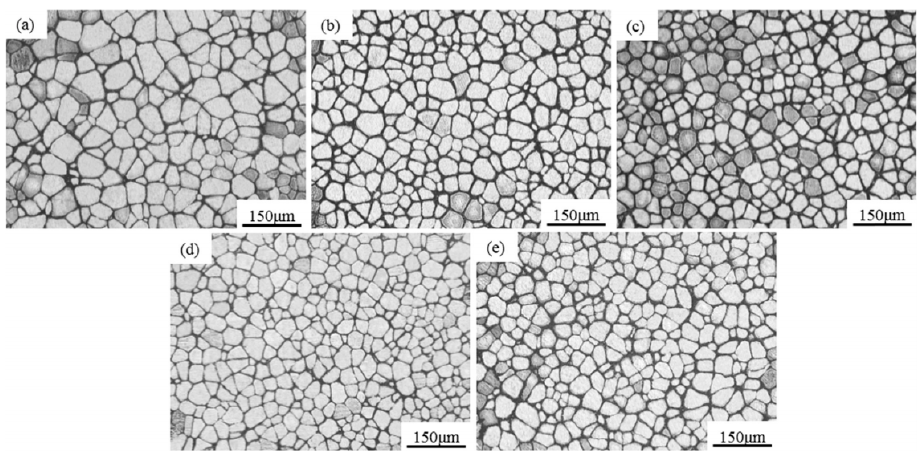
Figure 2. Optical micrographs of the as-cast ZE41-Ca-Sr alloys: ( a ) ZE41; ( b ) ZE41-0.2Ca; ( c ) ZE41- 0.2Ca-0.1Sr; ( d ) ZE41-0.2Ca-0.2Sr; ( e ) ZE41-0.2Ca-0.4Sr [24].